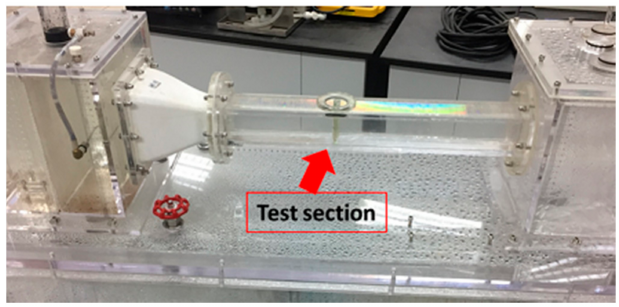
Figure 4. Water tunnel used for the underwater superhydrophobicity test in turbulent flow. Test section for the sample is located in the middle of the